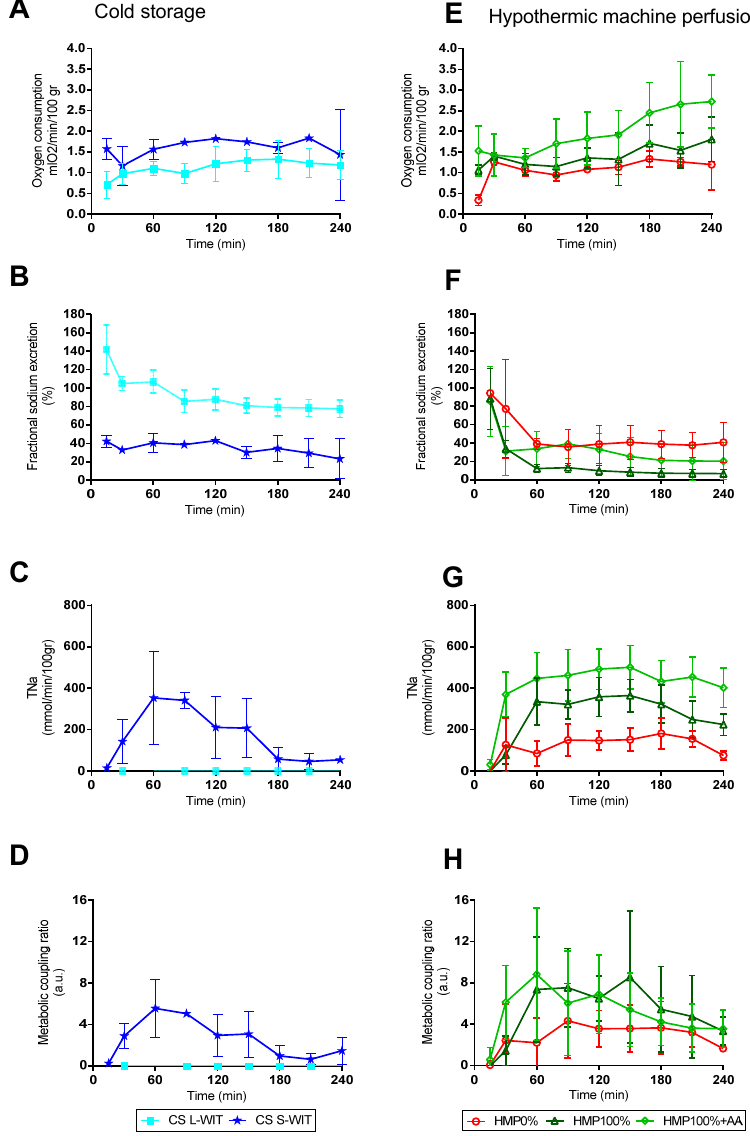
Figure 5. Metabolic processes during normothermic kidney perfusion. Porcine kidneys perfused for 4 h with a blood-based perfusion solution to test kidney function. ( A , E ) Oxygen consumption rates during 4 h NKP for CS and HMP preserved kidneys, ( B , F ) fractional sodium excretion levels (Fe Na ) during 4 h NKP for CS and HMP preserved kidneys, ( C , G ) total sodium reabsorption (T Na ) during 4 h NKP for CS and HMP preserved kidneys, ( D , H ) metabolic coupling ratio during 4 h NKP for CS and HMP preserved kidneys. NKP, normothermic kidney perfusion; CS, cold storage; HMP, hypothermic machine perfusion.The data are shown as mean ± SD. Fractional sodium excretion rates were high for group CS L-WIT ( ± 100%). All other groups showed improved fractional sodium excretion rates in comparison with this group. All groups, except for CS S-WIT, had a decrease in excretion levels between 15 and 60 min. The kidneys from group CS S-WIT immediately had a fractional sodium excretion rate of approximately 30–40% (Figure